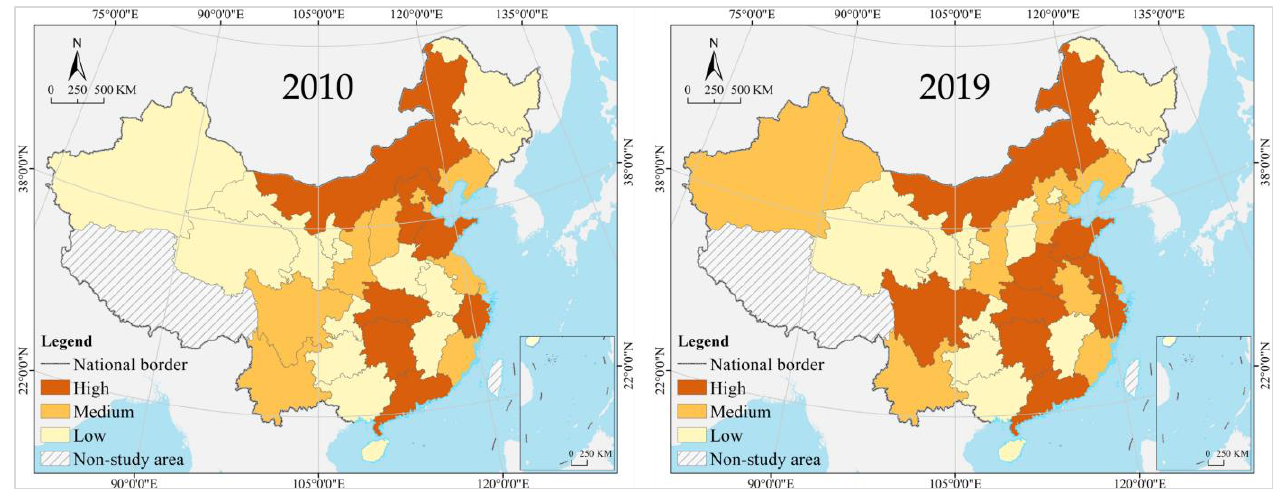
Figure 8. Spatial cluster of ECA in 2010 and 2019.